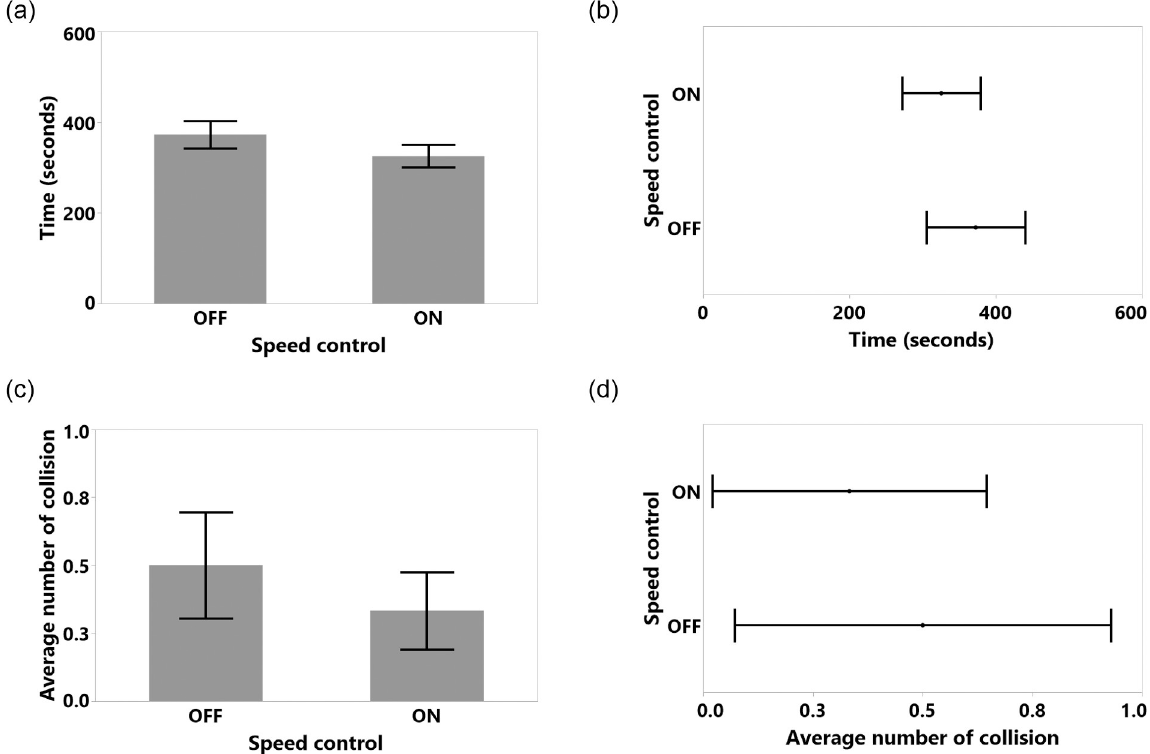
Fig 18. Study 2 SC task completion time (a) means and standard error of means, and (b) means and confidence intervals. Study 2 SC average number of collision for (c) means and standard error of means, and (d) means and confidence intervals.